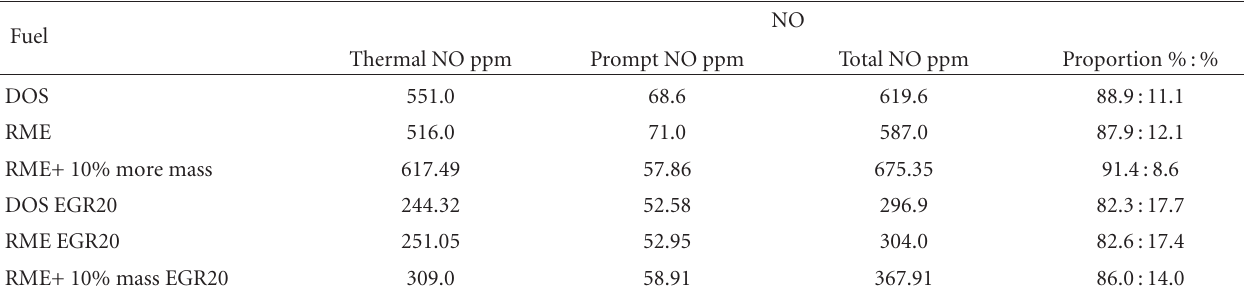
Table 6: The absolute NO concentration values contributed by di ff erent mechanisms for DOS, RME, and RME+ under 0% and 20% EGR level